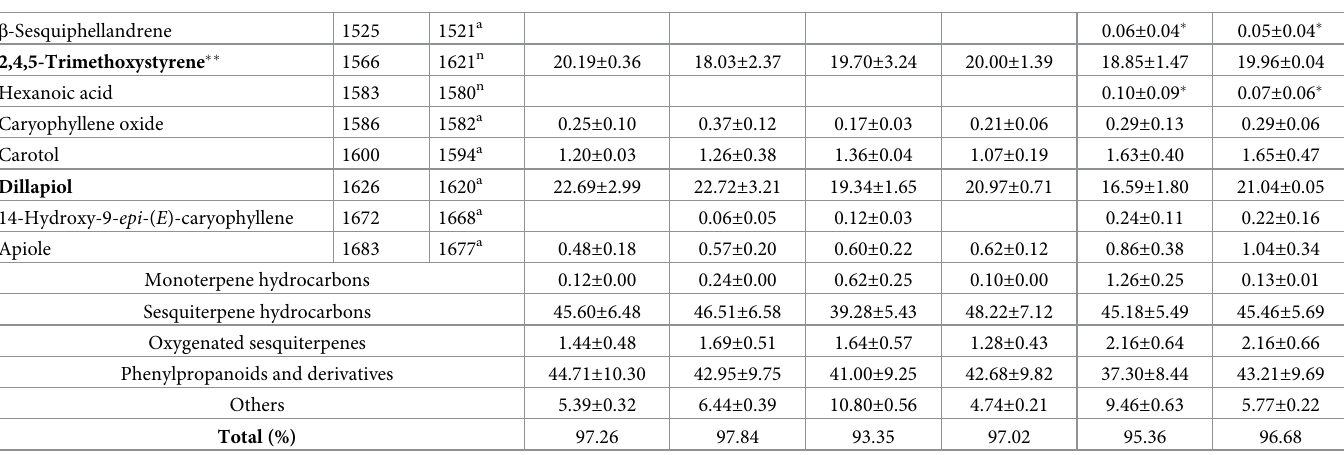
PpI-21, PpC-30 and PpI-30, stood out mainly for the similar concentration of β -elemene (3.06%, 3.54%, and 3.49%). These groups’ formation indicates that there was no significant dif- ference in the contents of the components of plants inoculated with K . variicola .